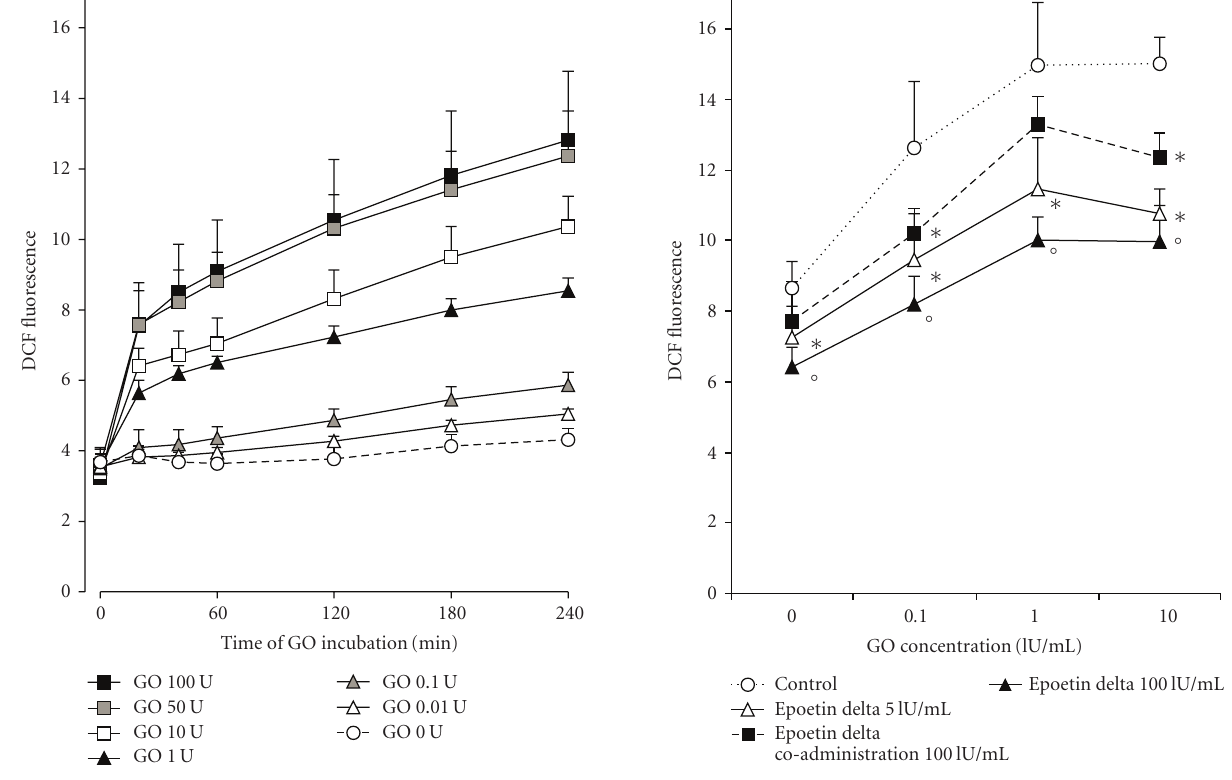
Figure 2: GO-induced oxidative stress (240 minutes) in hTECs either pre/coincubated with epoetin delta or not. Epoetin delta attenuated oxidative stress in a dose-dependent way by reducing ROS formation. The data are expressed as the mean ± SD of 4 monolayers per condition from a single experiment representative of 6 separate experiments. ∗ P < . 05, ◦ P < . 01 compared to the